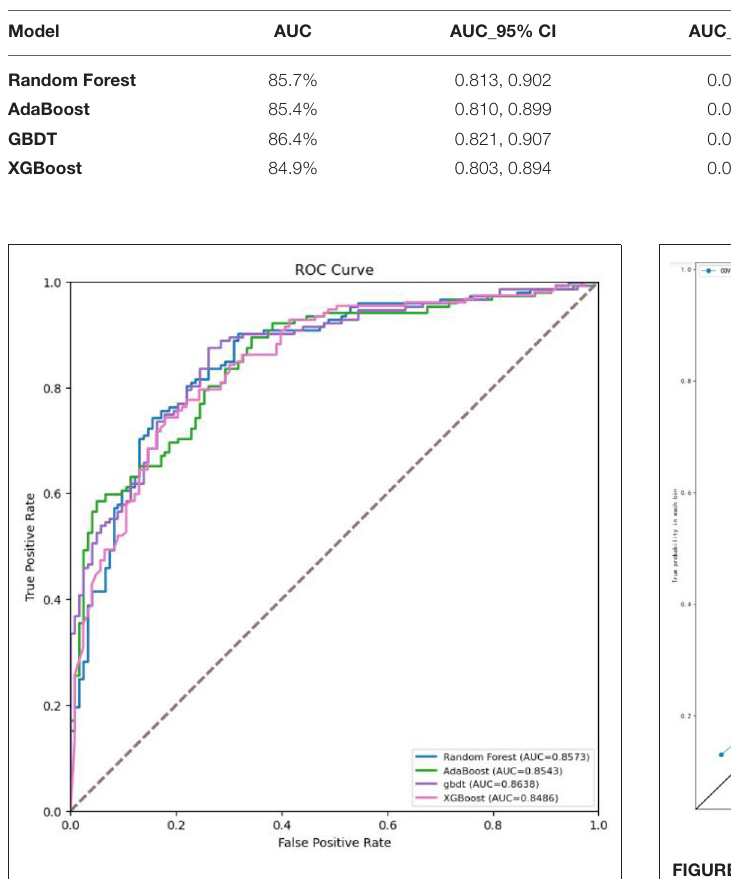
FIGURE 2 | Receiver operating characteristic (ROC) curves for the machine learning models in screening COVID-19.